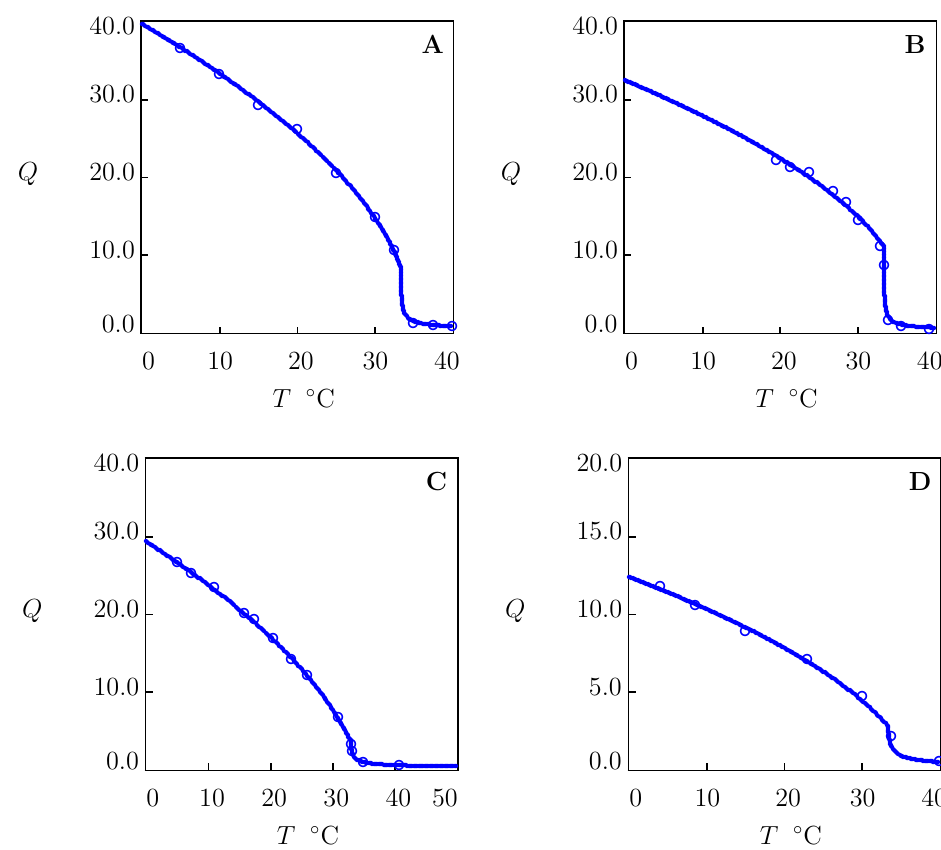
Figure 1. Equilibrium degree of swelling Q versus temperature T . Circles: experimental data on PNIPAAm gels in water. ( A )—[38], ( B )—[39], ( C )–[40], ( D )—[41]. Solid lines: results of numerical